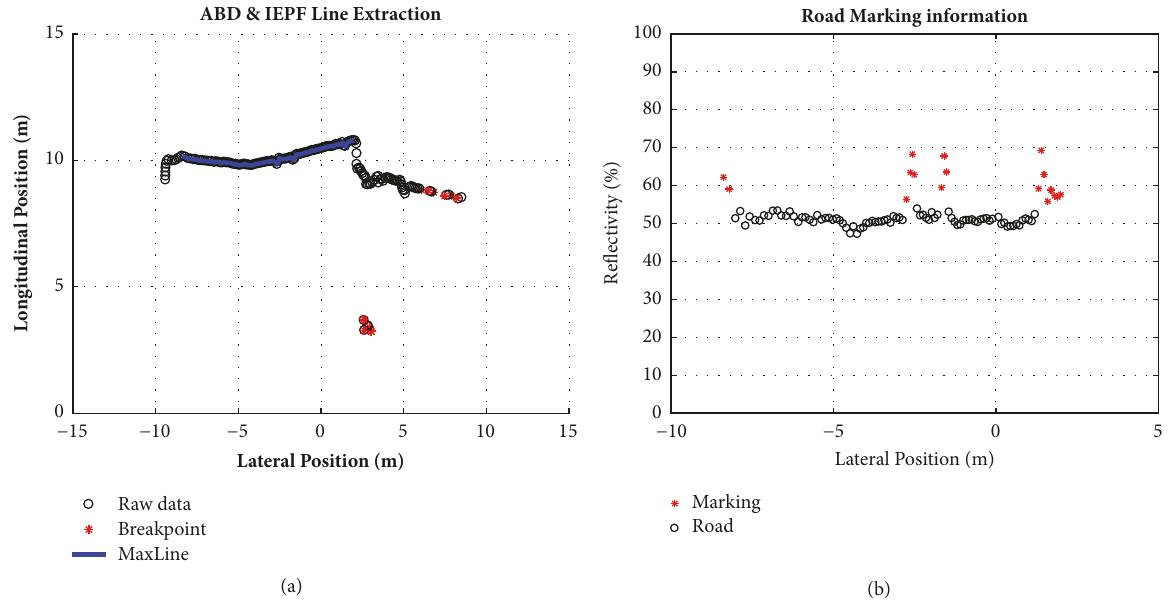
Figure 5: Result of the extraction of road markings and road region information: (a) the result of the road boundary extraction and (b) the result of the road marking extraction.